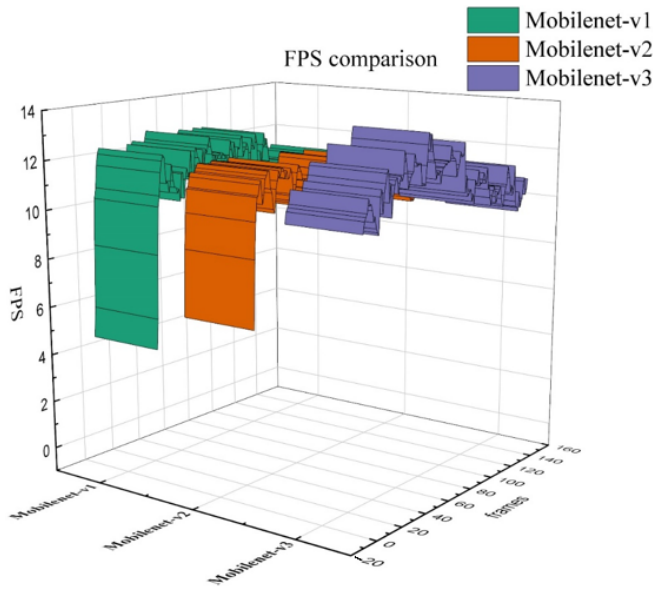
Figure 23. FPS comparison of Mobilenet-v1, v2, and v3.